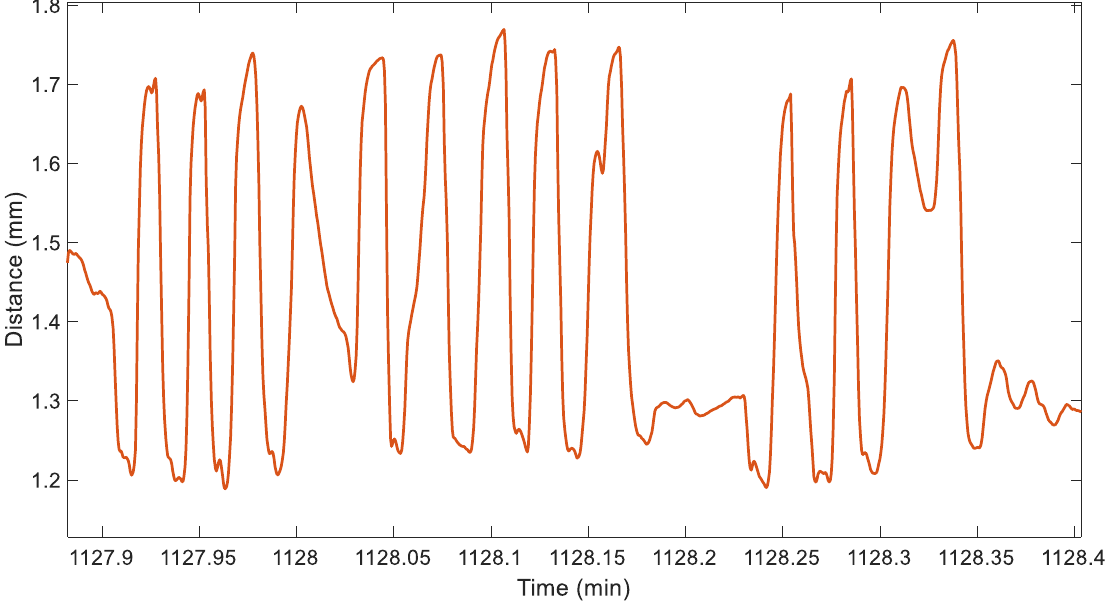
Figure A2. Example data from a participant during take-home testing. Approximately 0.5 min of data are shown.